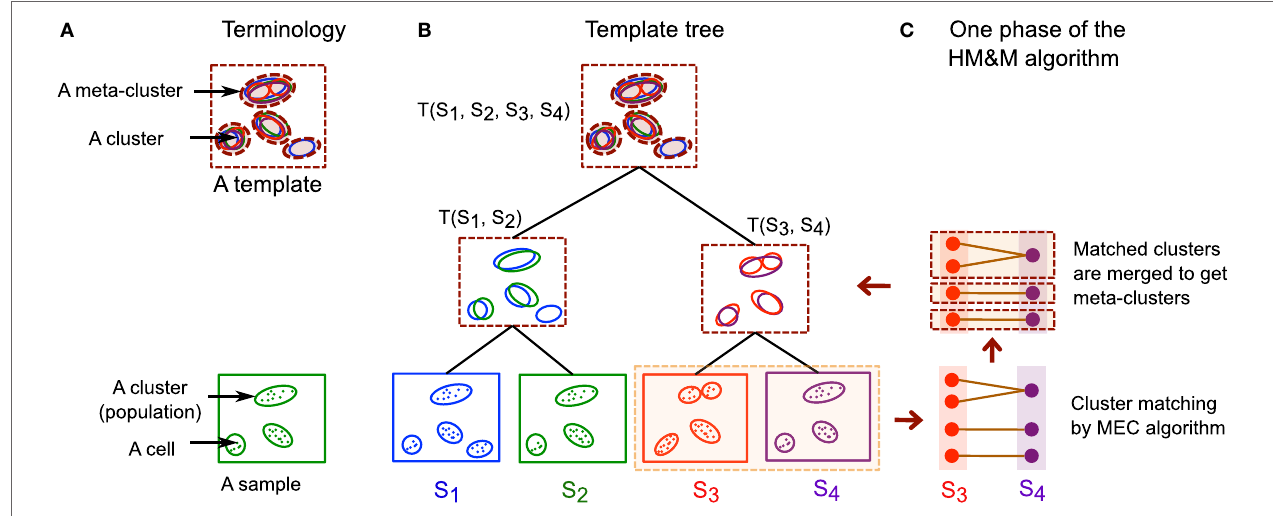
FigUre 4 | (a) Some of the terminologies used in this paper. A cell cluster or cell population is a group of cells expressing similar features, and an FC sample is a collection of cell clusters. A meta-cluster is a set of similar cell clusters from different samples, and a template is a collection of meta-clusters. Cells are denoted by dots, clusters by solid ellipses, and meta-clusters by dashed ellipses. (B) An example of a hierarchical template tree created from four hypothetical samples S 1 , S 2 , S 3 , and S 4 . A leaf node of the template tree represents a sample and an internal (non-leaf) node represents a template created from its children in the tree. The children could be templates if they are interior nodes or samples if they are leaves. (c) One step of the HM&M algorithm creating a template T ( S 3 , S 4 ) from a pair of samples. The algorithm first matches clusters (or meta-clusters) across samples (or templates) by the MEC algorithm and then merges the matched clusters to construct new